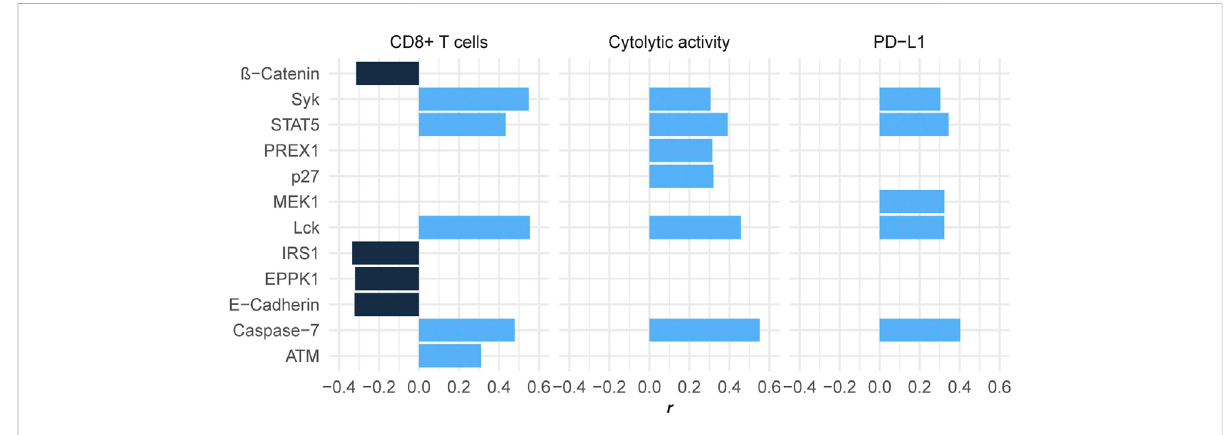
FIGURE 3 Proteins having signi fi cant expression correlations with CD8 + T cell enrichment, cytolytic activity, or PD-L1 expression in HCC (| r | > 0.3). The Pearson correlation coef fi cients ( r ) are shown.